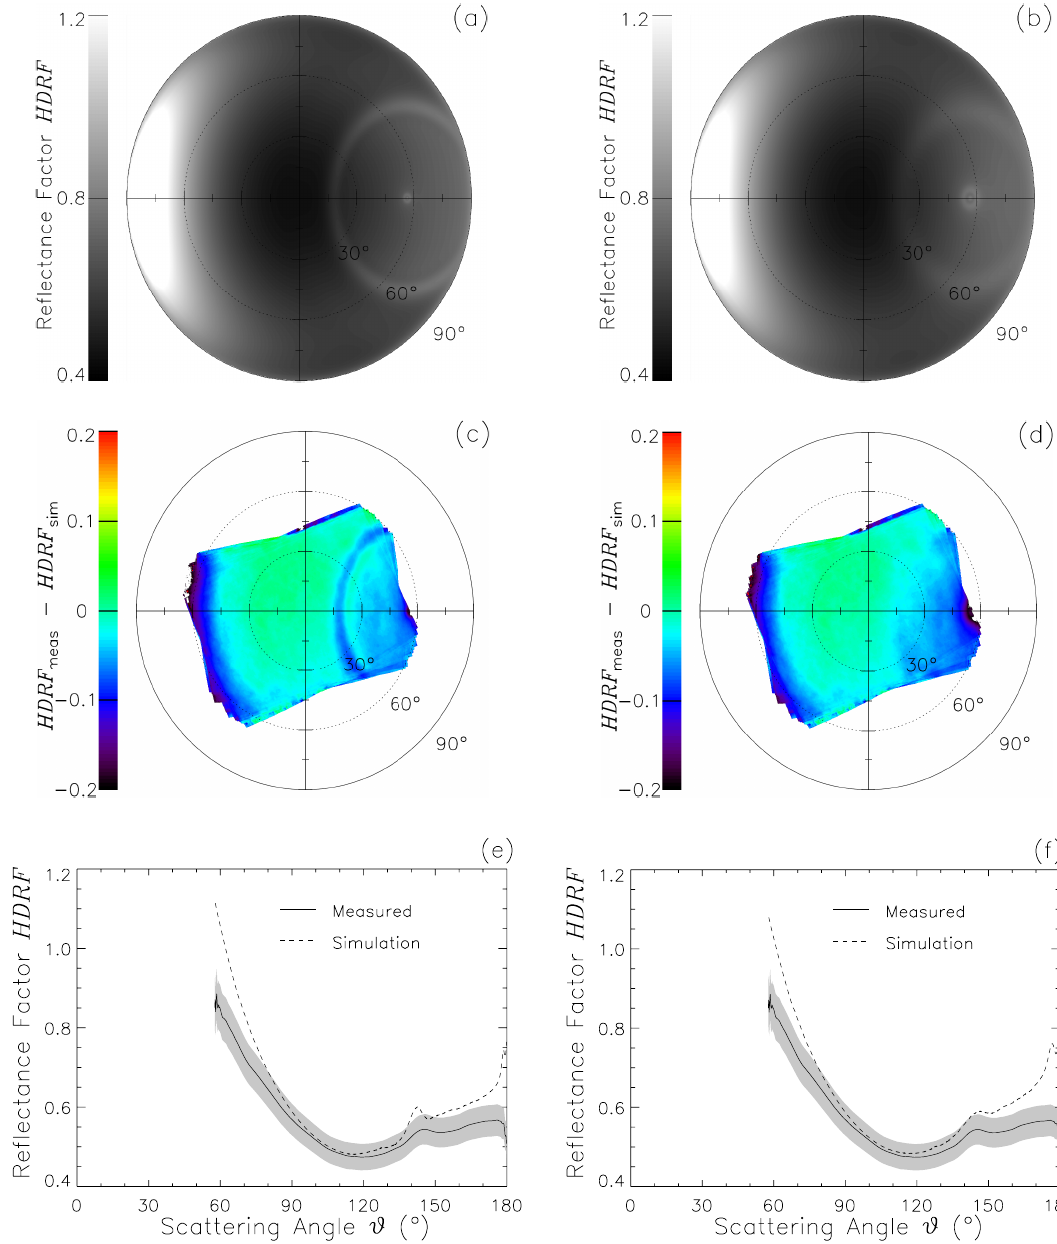
Fig. 10. Simulated HDRF for clouds with optical thickness and effective diameter of τ = 12 and R eff = 10µm (left) and of τ = 10, R eff = 4µm (right). The upper panels show the HDRF of the entire lower hemisphere. Differences between measured and simulated HDRF are given in the middle panels (c, d) . The lower panels (e, f) give the HDRF (ϑ) as function of the scattering angle for measurements and simulations. The uncertainty of the measurements is indicated by the gray